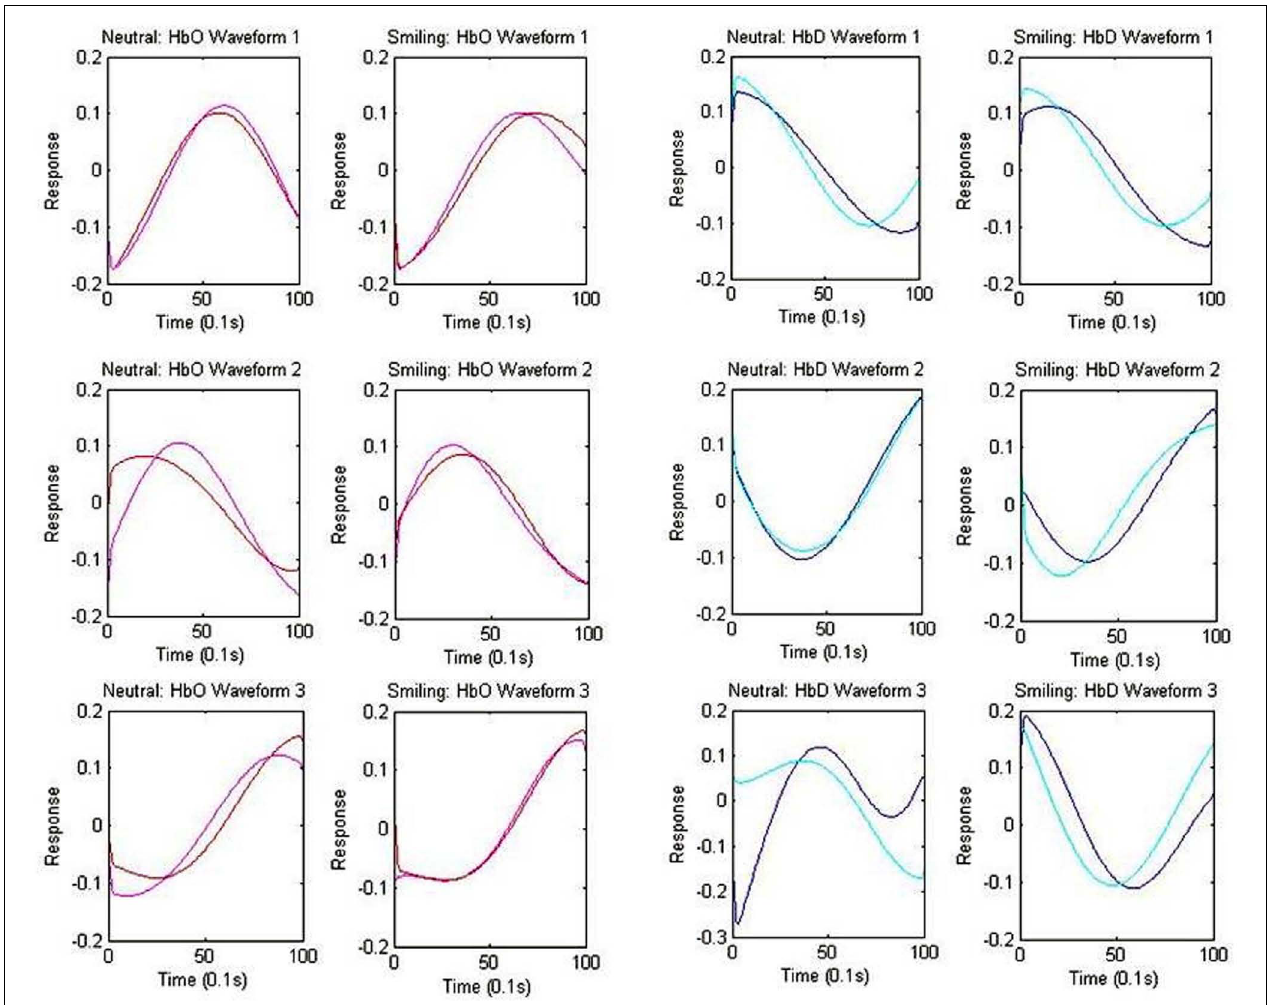
red = HRA, pink = LRC) and deoxy-hemoglobin (HbD: blue = HRA, cyan = LRC) components, for both the smiling and neutral conditions. Waveforms from the HRA and LRC groups are shown together based upon